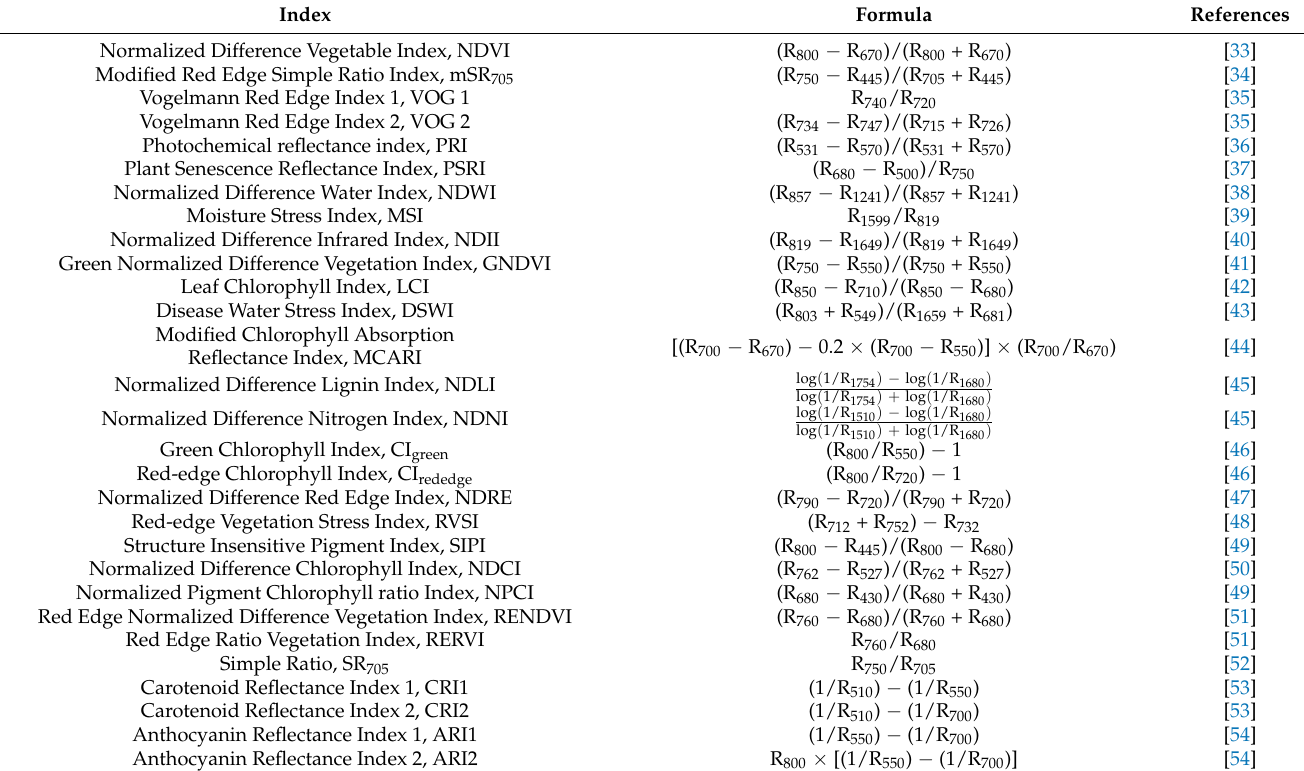
Table 1. Hyperspectral indices used for monitoring the physiological status of moso bamboo